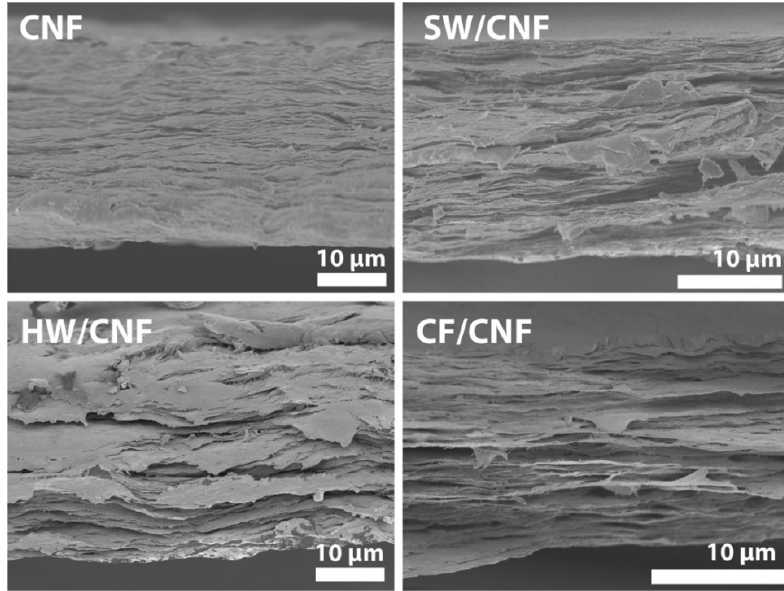
Figure 5. Cross-sectional SEM images of composite lignocellulose membranes.